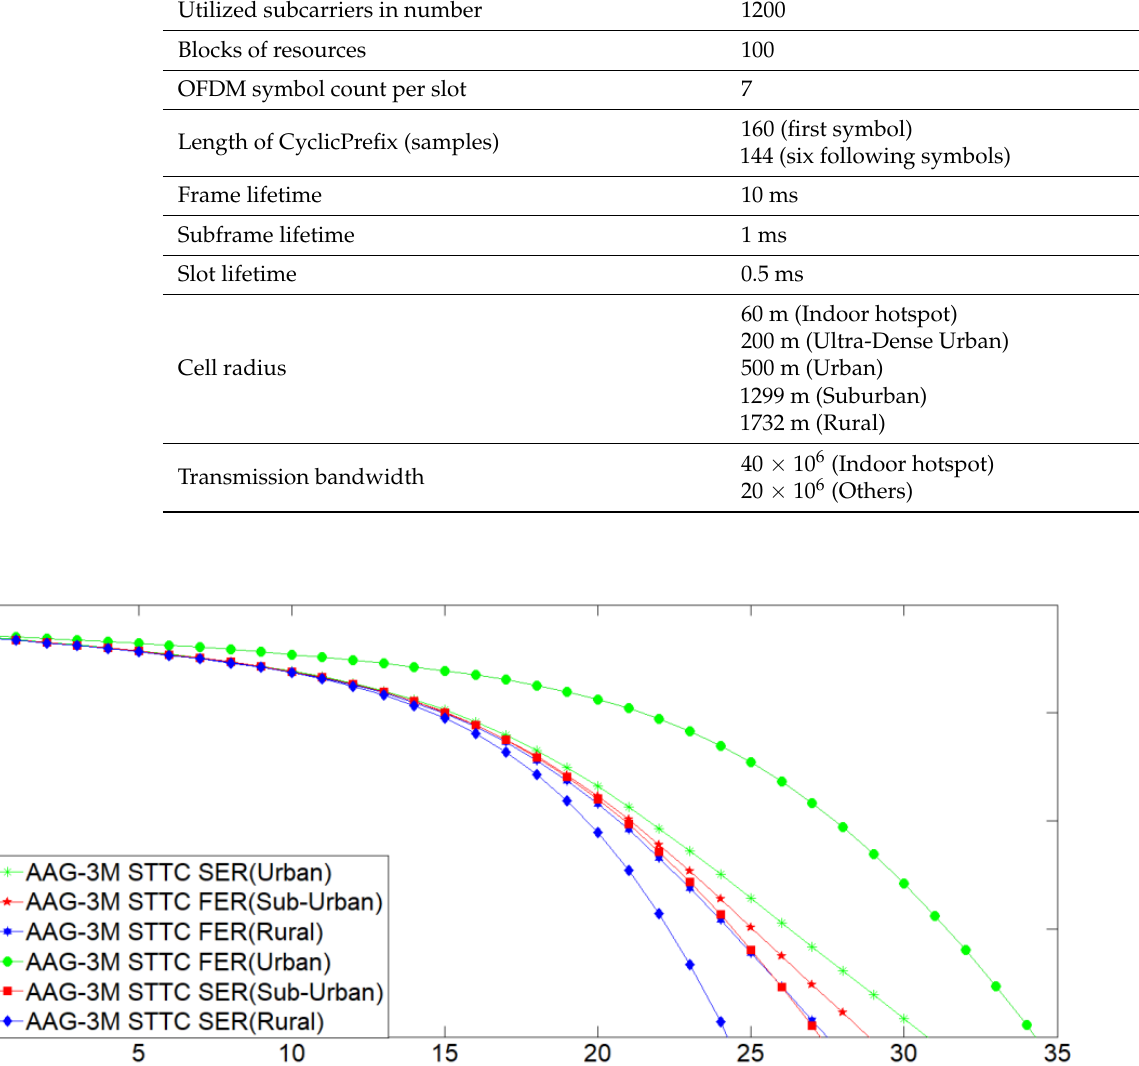
Figure 5. Comparison of Indoor hotspot and Ultra-Dense Urban deployment for AAG-3M STTC with Massive MIMO in terms of FER and SER.